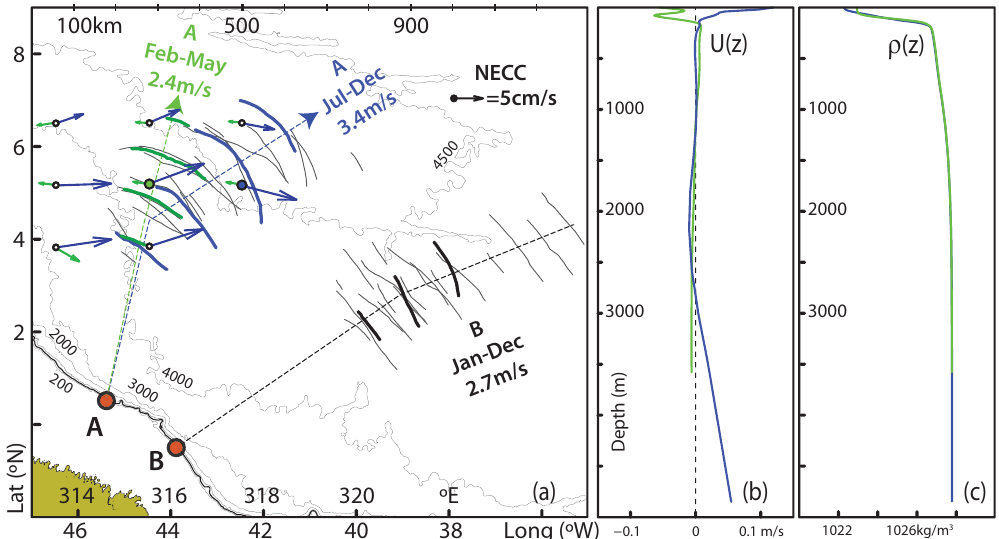
Figure 9. (a) Same composite map as in Fig. 1 is shown in thin black lines, with two case studies highlighted in thick coloured lines, corresponding to location A and representative of two different seasons: from February to May (in green and dated 27 May 2009) and from July to December (in blue and dated 3 October 2011). Their averaged propagation speeds are also indicated along with idealized propagation paths (in thin dashed lines). Corresponding NECC monthly means (in green and blue for May and October, respectively) are shown to depict its seasonal character along the ISW propagation paths (see also scaled arrow in black). For reference, the case study shown in Fig. 3b is also highlighted in thick black lines, along with its mean propagation speed. Depth contours for 200, 500, 1000, 2000, 3000, 4000, and 4500m are given in thin grey lines. Note the 200 and 1000m contours are hardly distinguishable from the 500m isobath (highlighted in a thick black line), and thus representative of a steep shelf break. (b) Climatological monthly means for horizontal velocity vertical profiles projected along the ISW idealized propagation path, taken at green- and blue-filled circles in (a) (for May and October, respectively). (c) Same as (b) but for potential density vertical profiles. See text for more